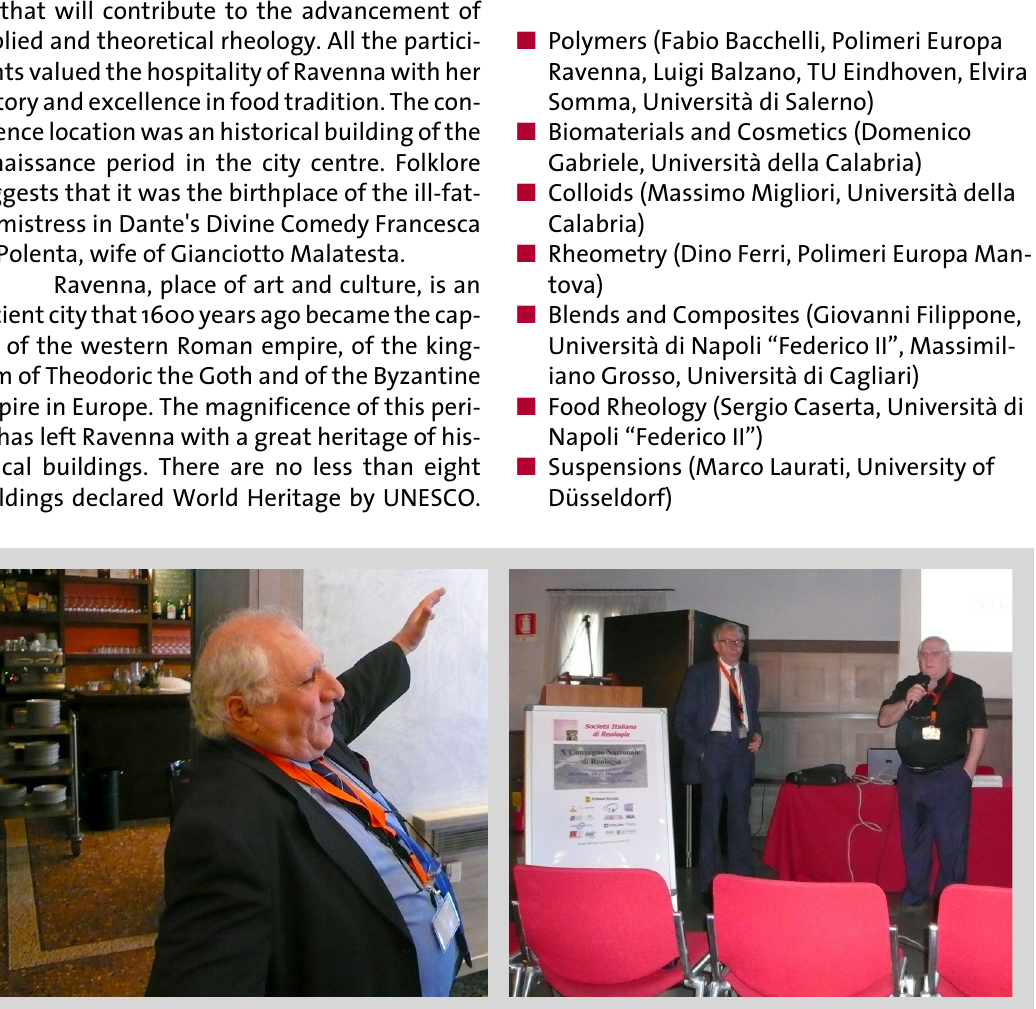
Figure 1 (left above): Main geographic distribu- tion of the conference par- ticipants. Figure 2 (right above): Christian Bailly during his keynote lecture. Figure 3 (left below): Bruno de Cindio, president of the Italian Society of Rheology. Figure 4 (right below): Giuseppe Marrucci and Bruno de Cindio opening the 2nd day of